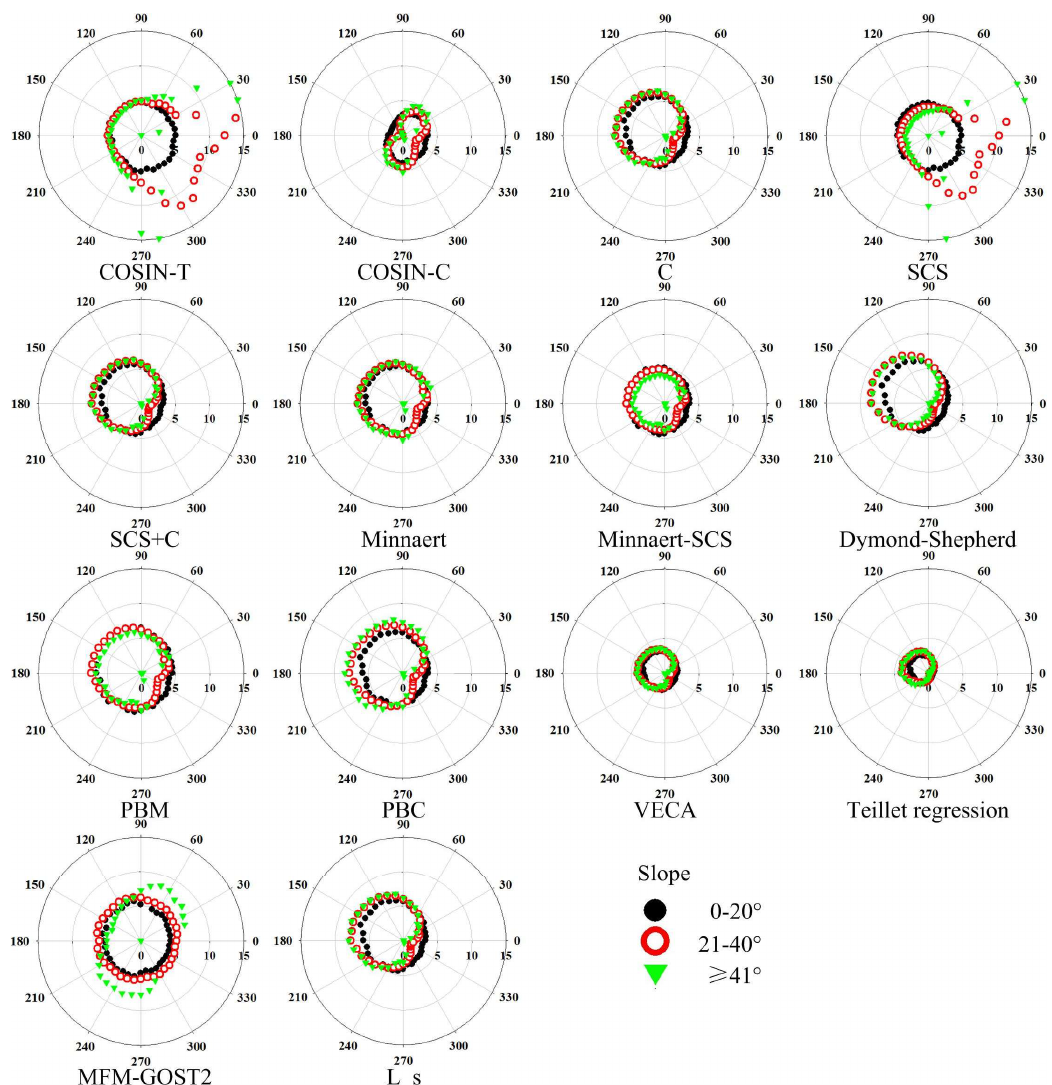
Figure 7. Changes of mean radiances in the SWIR band with the aspect at fixed slope intervals in the study area. The polar angle represents the aspect of background (°), and the radius represents the value of radiances (W/(m 2 ·sr·μm)). L_s is the uncorrected radiance.